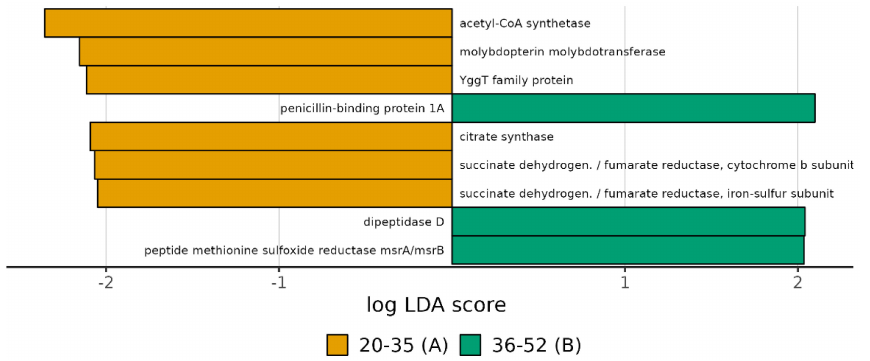
Figure 6. Computed LDA scores of the significantly different functions in A and B groups. Negative LDA scores (yellow) are enriched in the A group while positive LDA scores (green) are enriched in the B group.